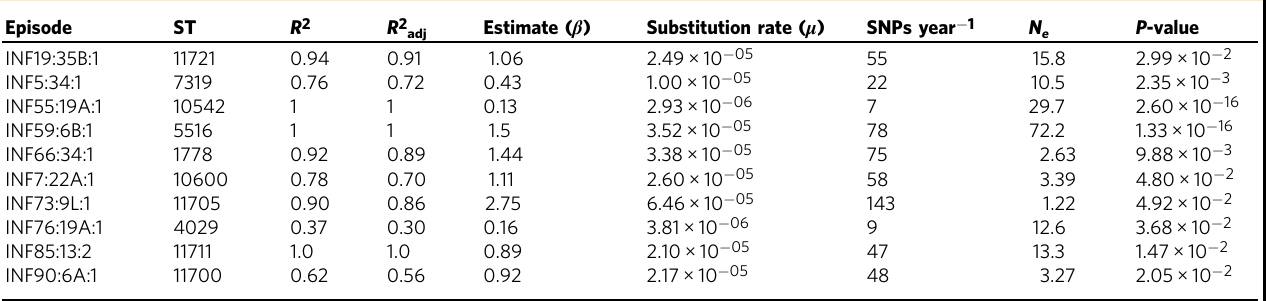
R 2 and N e denotes coef fi cient of determination and effective population size respectively. The estimated value for the regression coef fi cient ( β ) is expressed as SNPs per week. The estimates for μ are expressed SNPs site − 1 year − 1 and were extrapolated from β . Serotypes with >4 sequenced genomes per individual were